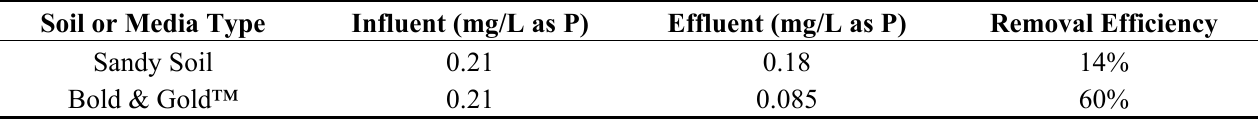
Table 2. Column test results for total